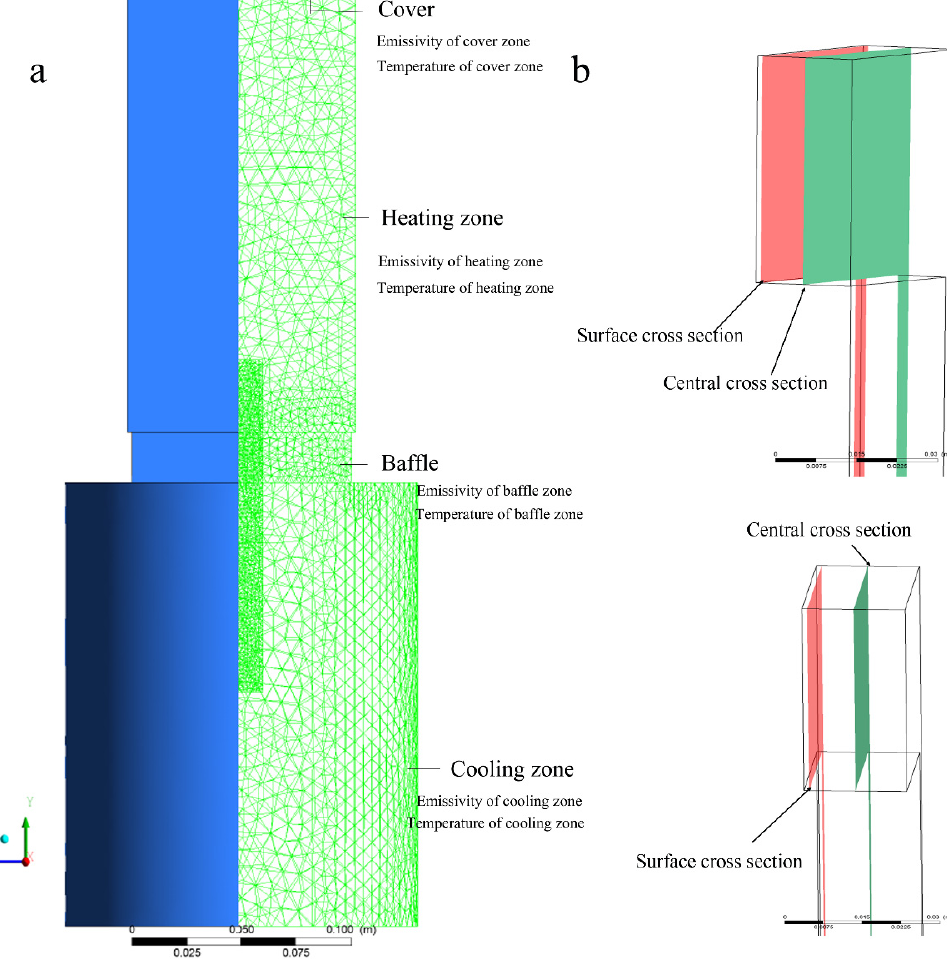
Table 2. Physical parameters of the FEM model.